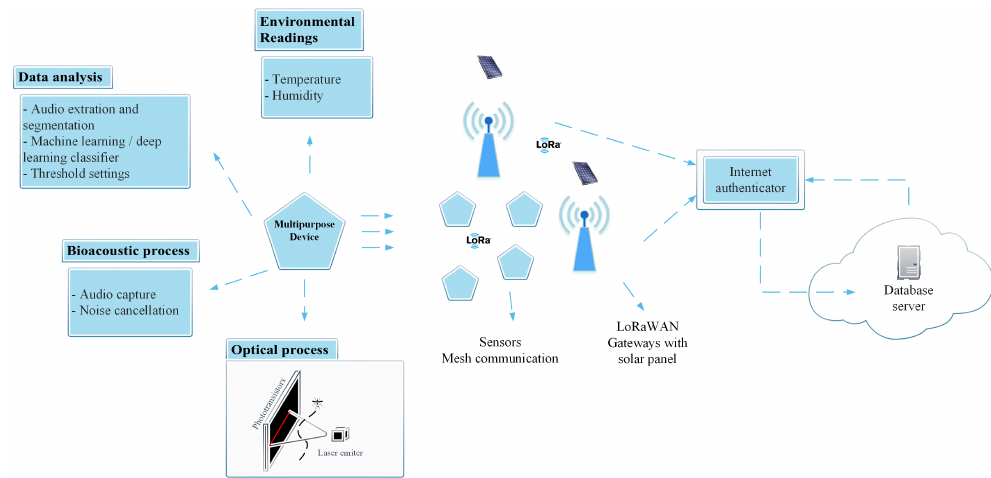
Figure 1. Multipurpose sensor